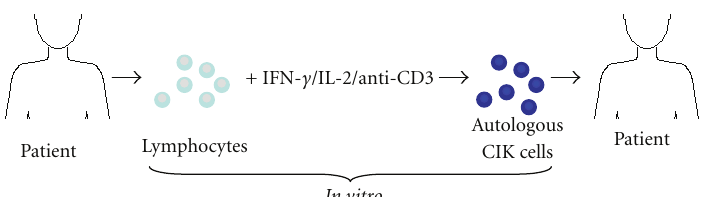
Figure 1: Generation and clinical application of CIK cells. Lymphocytes are extracted from the patients’ blood and stimulated with di ff erent cytokines. The resulting CIK cells are re-infused into the patient. IFN- γ : interferon- γ ; IL-2: interleukin-2; anti-CD3: anti-human CD3 monoclonal